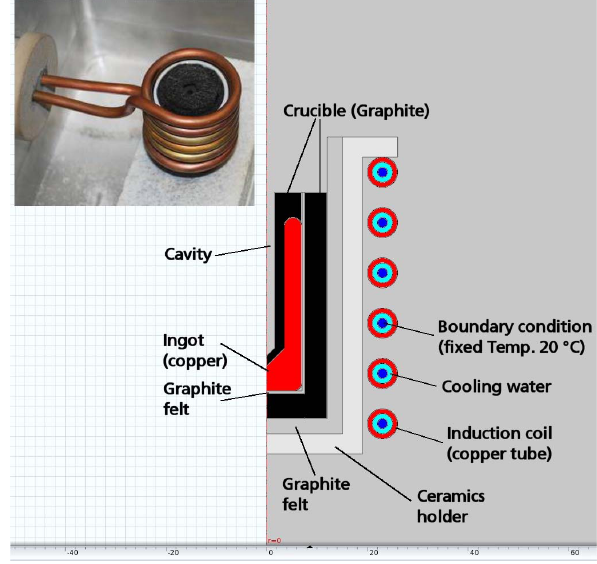
Figure 5. Components of radial symmetrical computer model for induction heating of fixed-point cells. Dimension of the cell: diameter 25mm × length 45mm. Photograph shows the technical implementation